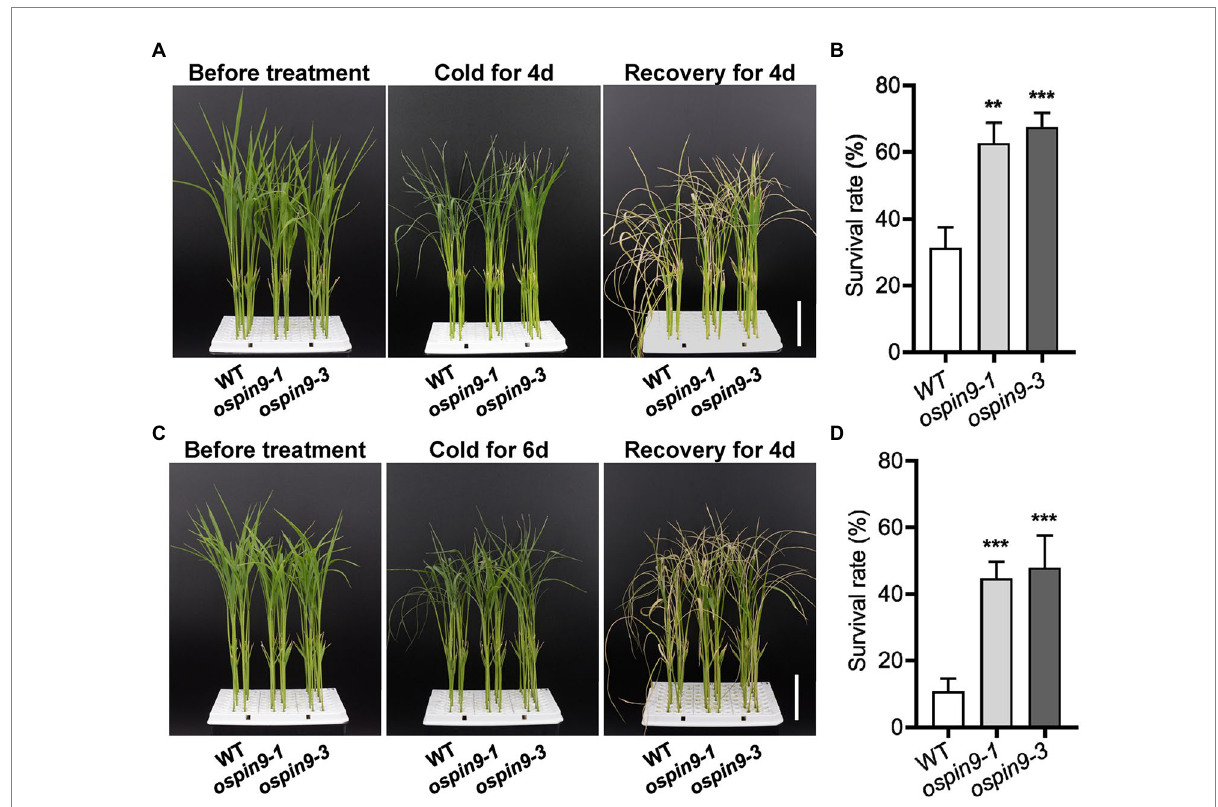
FIGURE 4 Mutation of OsPIN9 enhanced chilling tolerance in rice. (A) Phenotype of WT and ospin9 mutants before chilling treatment, after chilling treatment for 4 days and recovery for another 4 days. Bar = 4 cm. (B) Statistical presentation of survival rate after chilling 4 days and recovery for another 4 days. (C) Phenotype of WT and ospin9 mutants before chilling treatment, after chilling treatment for 6 days and recovery for another 4 days. Bar = 4 cm. (D) Statistical presentation of survival rate after chilling 6 days and recovery for another 4 days. Values are means ± standard deviation (SD; n ≥ 30). Data were analyzed by ANOVA and Tukey’s tests at p < 0.05 significant